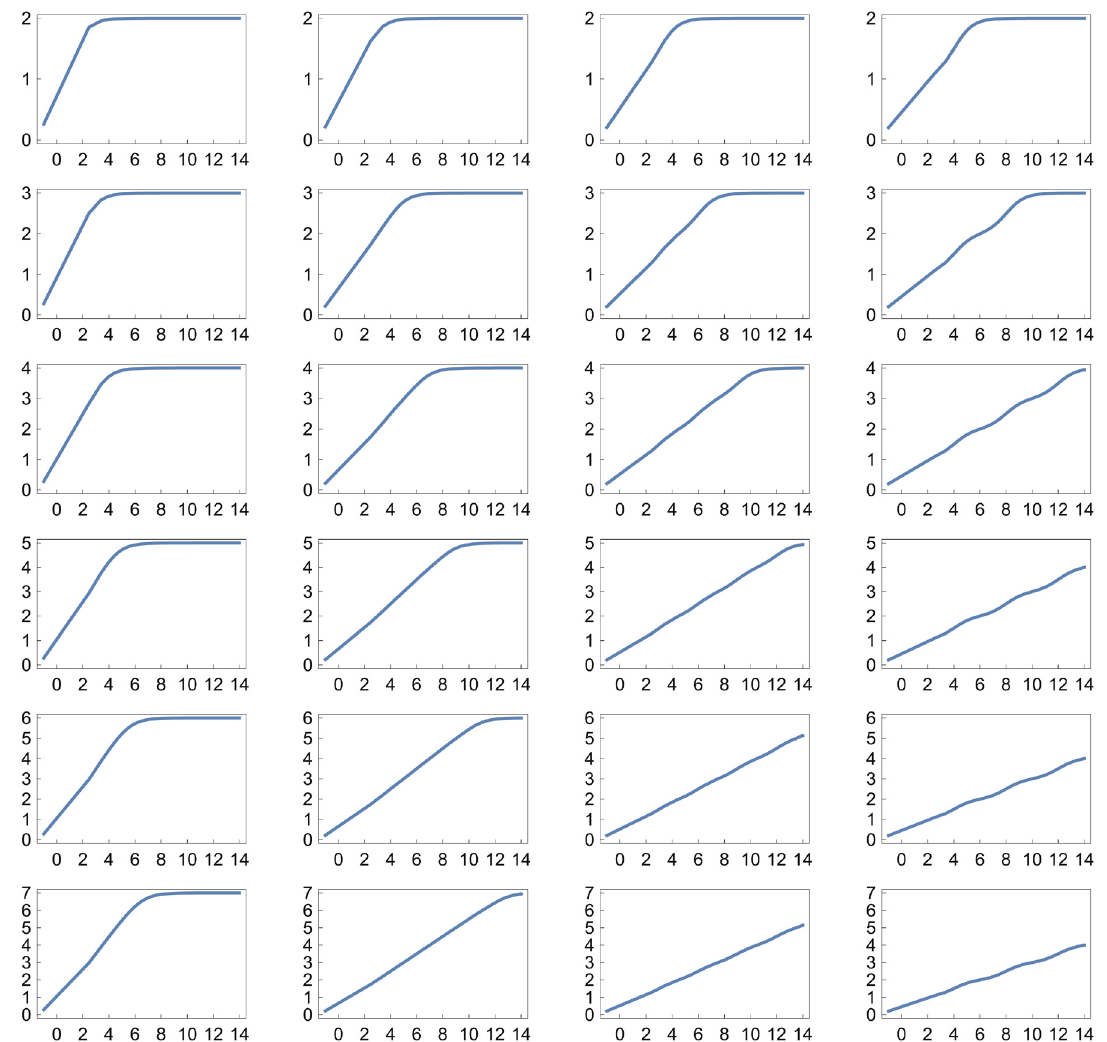
Figure 3. The logarithmic sensor response as in Figure 2, with Hill equation coefficient k = 2 (see Data availability).